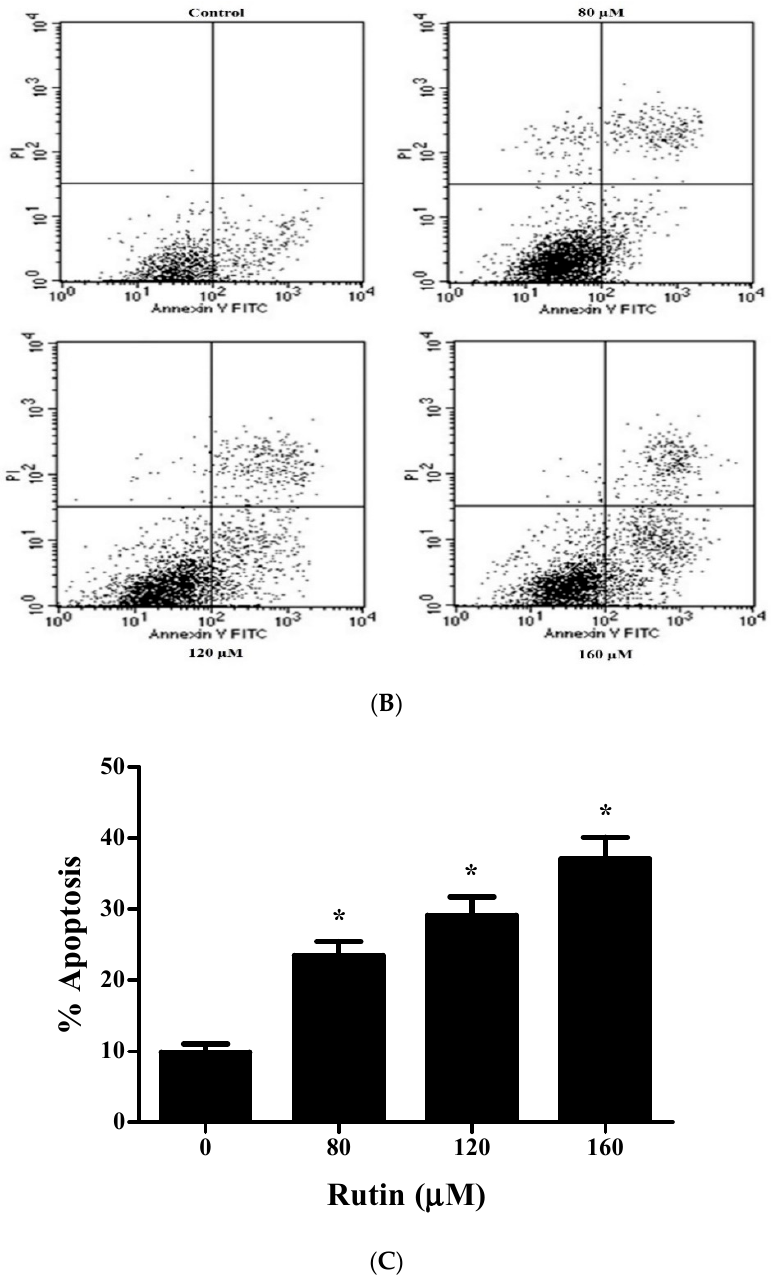
Figure 3. Apoptosis induction in rutin-treated SiHa cancer cells. ( A ) Nuclear morphology alteration of rutin-treated SiHa cells analyzed by DAPI staining method and visualized under fluorescence microscope. ( B ) Histogram representing percent apoptosis in rutin-treated SiHa cells for 24 h examined by flow cytometric analysis. ( C ) Percentage of rutin-induced apoptotic cells in cervical cancer SiHa cells examined by Annexin V-FITC/PI assay (* p < 0.05 compared with control group).